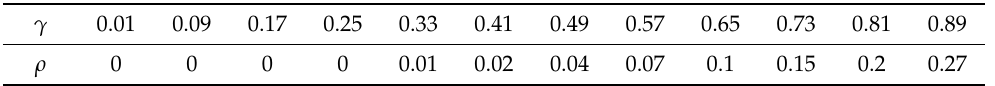
√ √ γ ,1/ γ ) and several